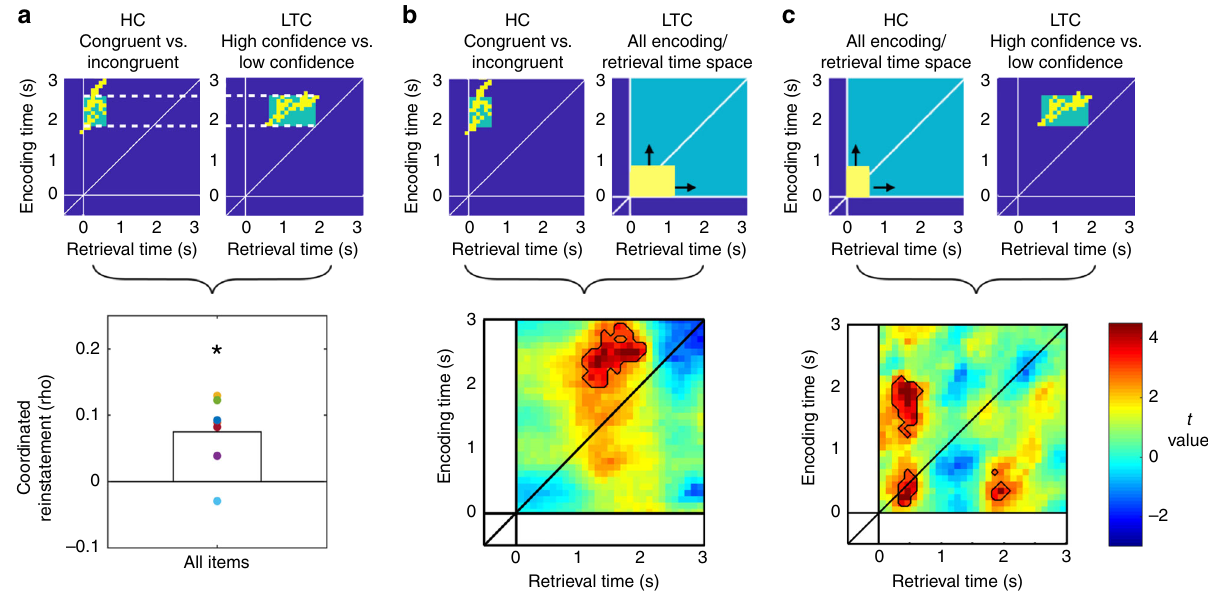
Fig. 5 Coordination of representational reinstatement between HC and LTC. a Encoding time-matched temporal regions of interest (tROIs) were de fi ned based on the signi fi cant clusters supporting reinstatement of item-context associations in the hippocampus and con fi dence effects in the lateral temporal cortex. Reinstatement values were correlated across trials in each patient. * indicates a p- value below 0.05 (one-sample t -test). b Correlation map between the hippocampal tROI cluster and all encoding-retrieval time pairs (0 – 3 s) in the lateral temporal cortex (cluster equally sized as in panel a , top right). c Correlation map between the LTC cluster and all encoding-retrieval time pairs in the HC. Bottom parts of panels b and c show T -maps in which correlations against zero at the group level were tested for the corresponding analysis. Areas in which values reached signi fi cance at p (uncorrected) < 0.05